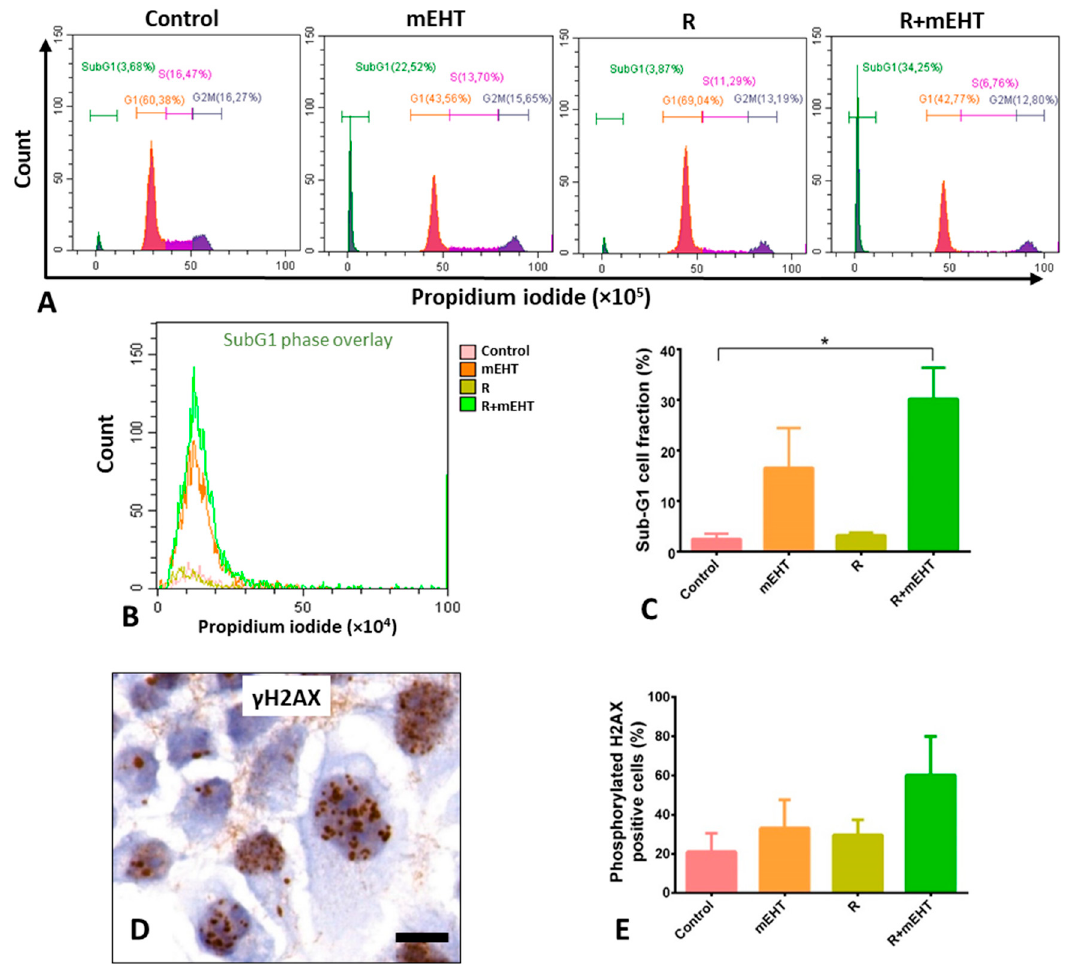
Figure 5. Treatment related elevated subG1-fractions and moderate increase in nuclear phosphorylated H2AX protein levels in Panc1 cultures 24 h post-treatment. Representative flow cytometry graphs of cell cycle fractions ( A ). A summary ( B ) and graphical representation of subG1-phase fractions ( C ) showing strong significance among the 4 groups ( p = 0.0006), which was confirmed with the Dunn’s test between R+ mEHT treatment and the controls ( p = 0.028). Upregulated granular γ H2AX foci in tumor cell nuclei after combined R+mEHT treatment ( D , scale bar: 10 µm) and their graphical representation after quantification ( E ), whose difference, however, did not reach significance compared to the controls. The asterisk (*) marks the value of p ≤ 0.05.